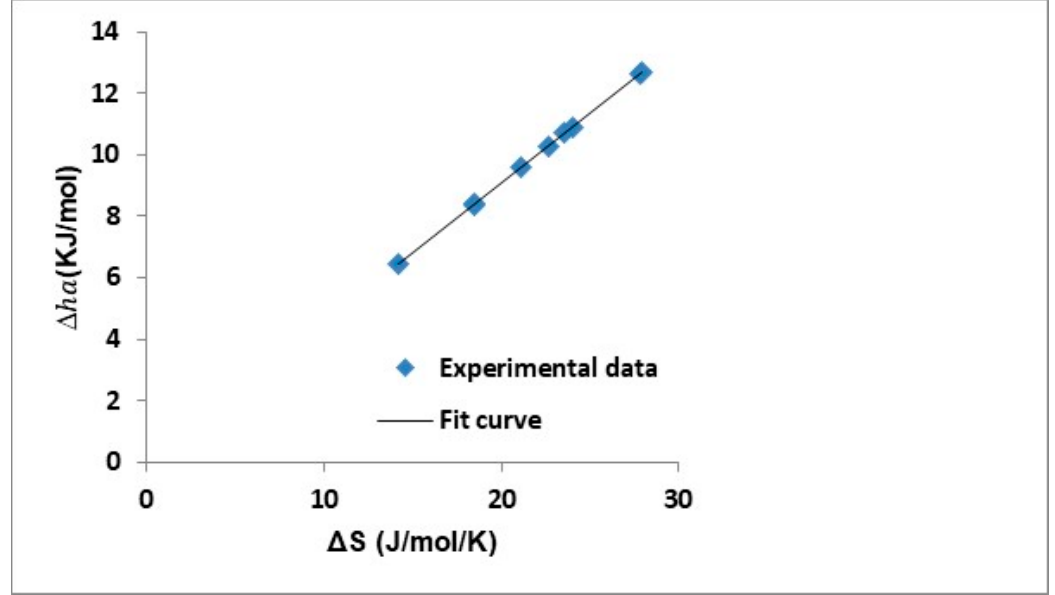
Figure 14. Enthalpy–entropy relationship in the corn kernel.